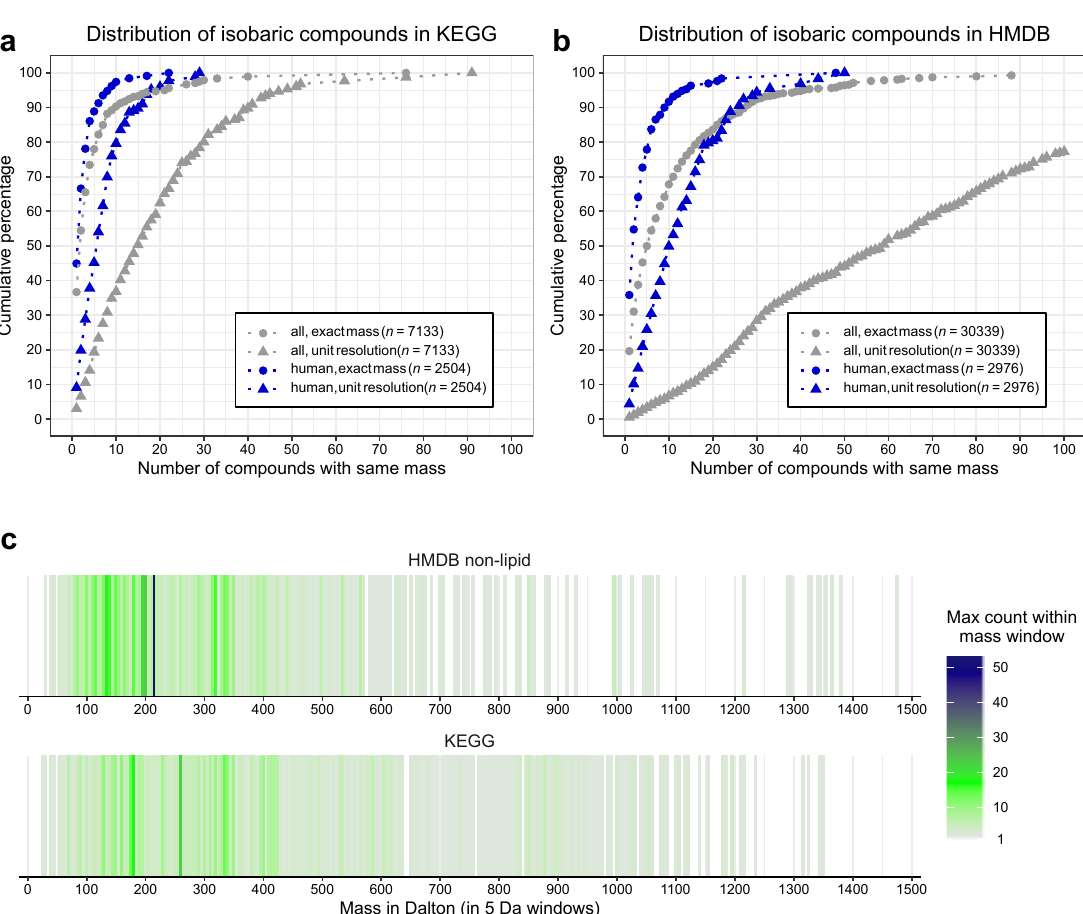
Figure 1. Compound similarities in common metabolite databases. ( a ) Cumulative percentage of isobaric metabolites extracted from the KEGG-database. “All” denotes organic metabolites with associated enzymatic reaction, “human” a subset with associated pathways in humans, “exact masses” indicate the exact mass as contained in the database, while “unit resolution” counts the frequencies with rounded masses. ( b ) Cumulative proportion of isobaric metabolites extracted from the human metabolome database (HMDB). “All” denotes non-lipid metabolites in the HMDB, while “human” denotes metabolites listed as “detected” or “quantified”. ( c ) Distribution of shared masses over the mass-range. Isomers were counted on the respective human dataset for exact mass. Each line represents a 5Da mass window, with the maximum of the counts within the window indicated by